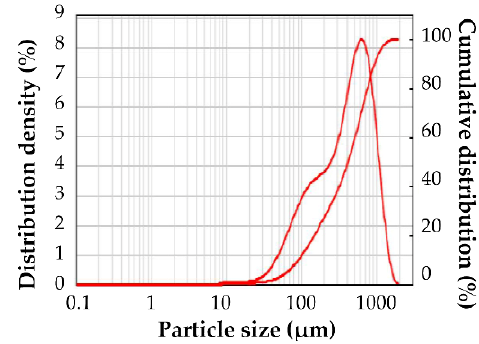
Figure 2. Particle size distribution of cork waste.